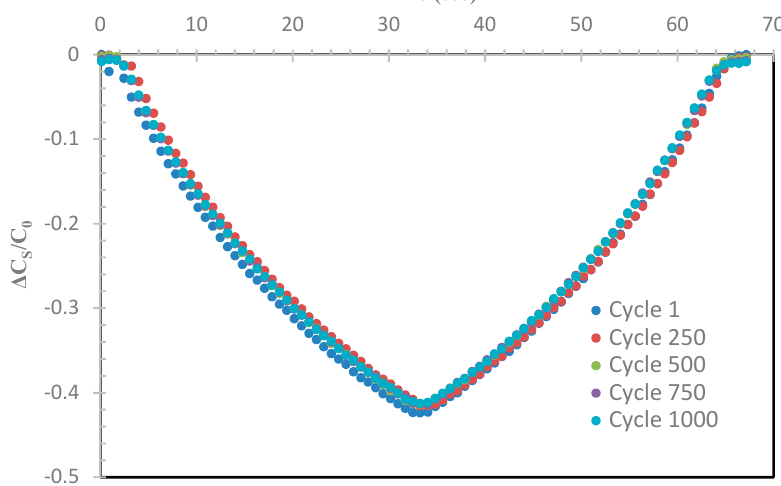
Figure 11. The Δ C S /C 0 versus time as the sensor was stretched to a maximum of 100% strain.